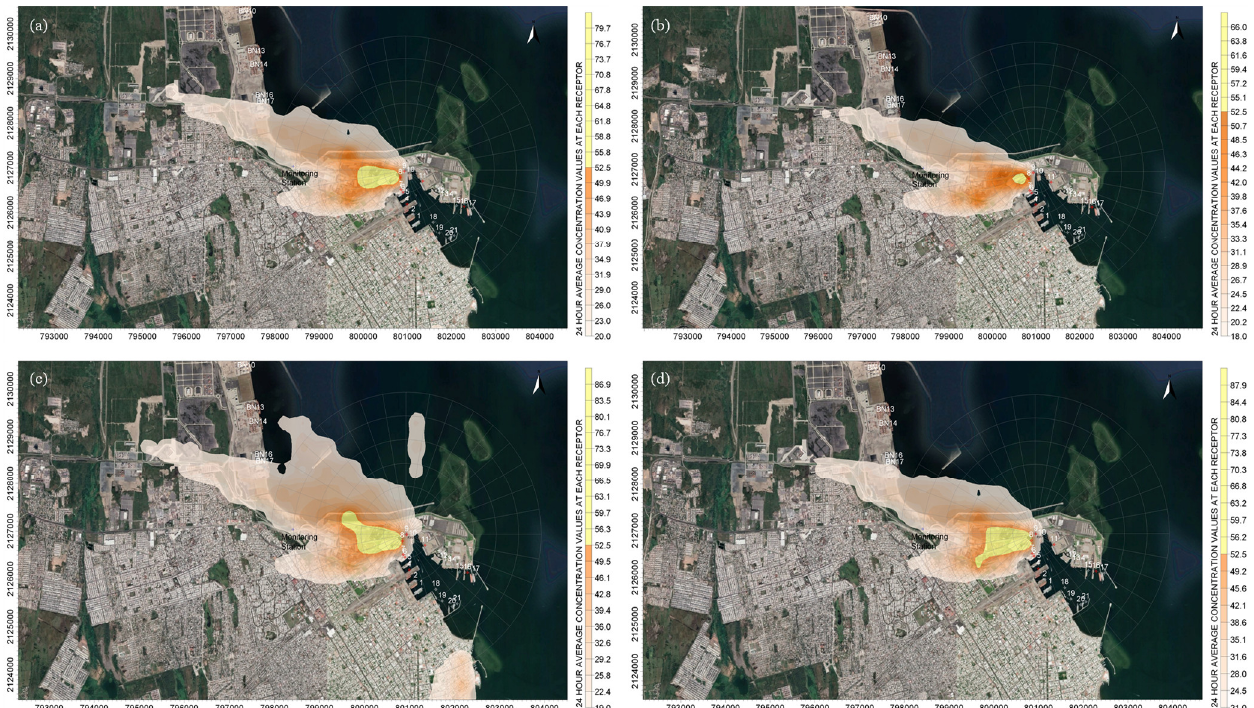
Figure 12. Impact on air quality in the city of Veracruz according to the CALPUFF model for ( a ) [103], ( b ) [104], ( c ) [106], and ( d ) [107].